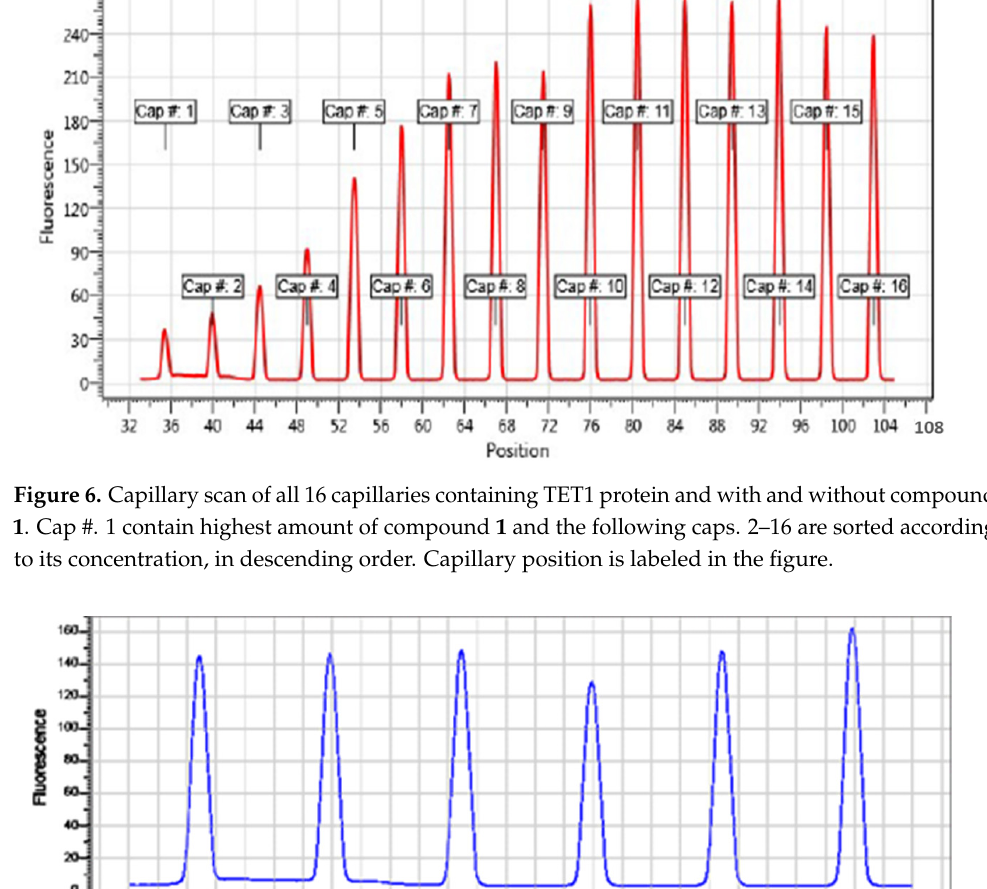
Figure 7. Fluorescence of bound and unbound state after denaturation of the TET1 protein.